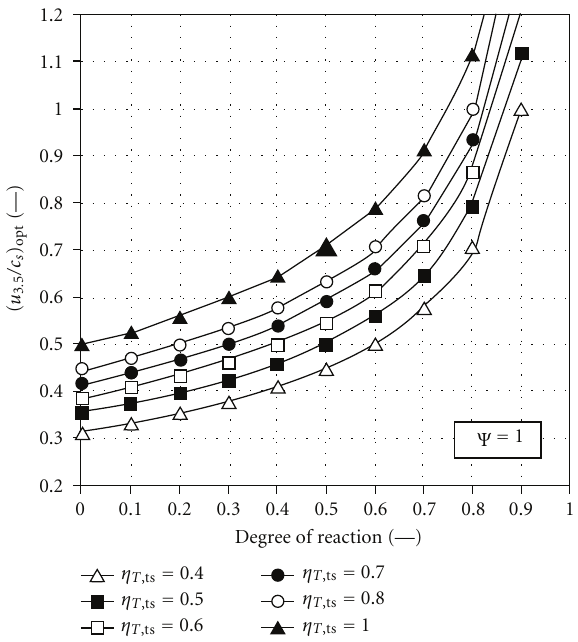
Figure 10: Optimum u 3 . 5 /c s versus degree of reaction in depen- dency on turbine e ffi ciency.